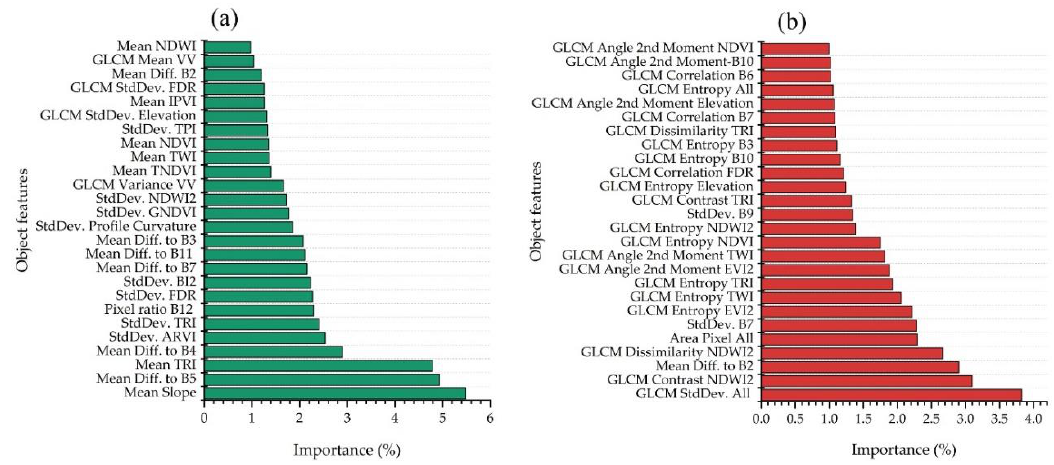
Figure 9. The top final object features contributed to mapping historical landslides using the object-oriented random forest in the protected ( a ) and non-protected ( b ) forests of the Hyrcanian ecoregion, NE Iran.